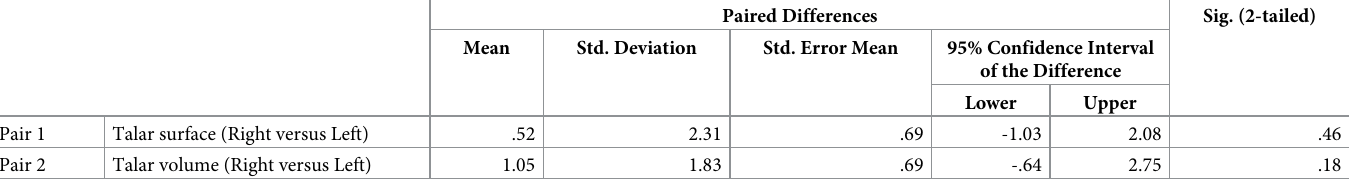
Table 4. Differences of geometric profiles from 11 matched pairs of tali.